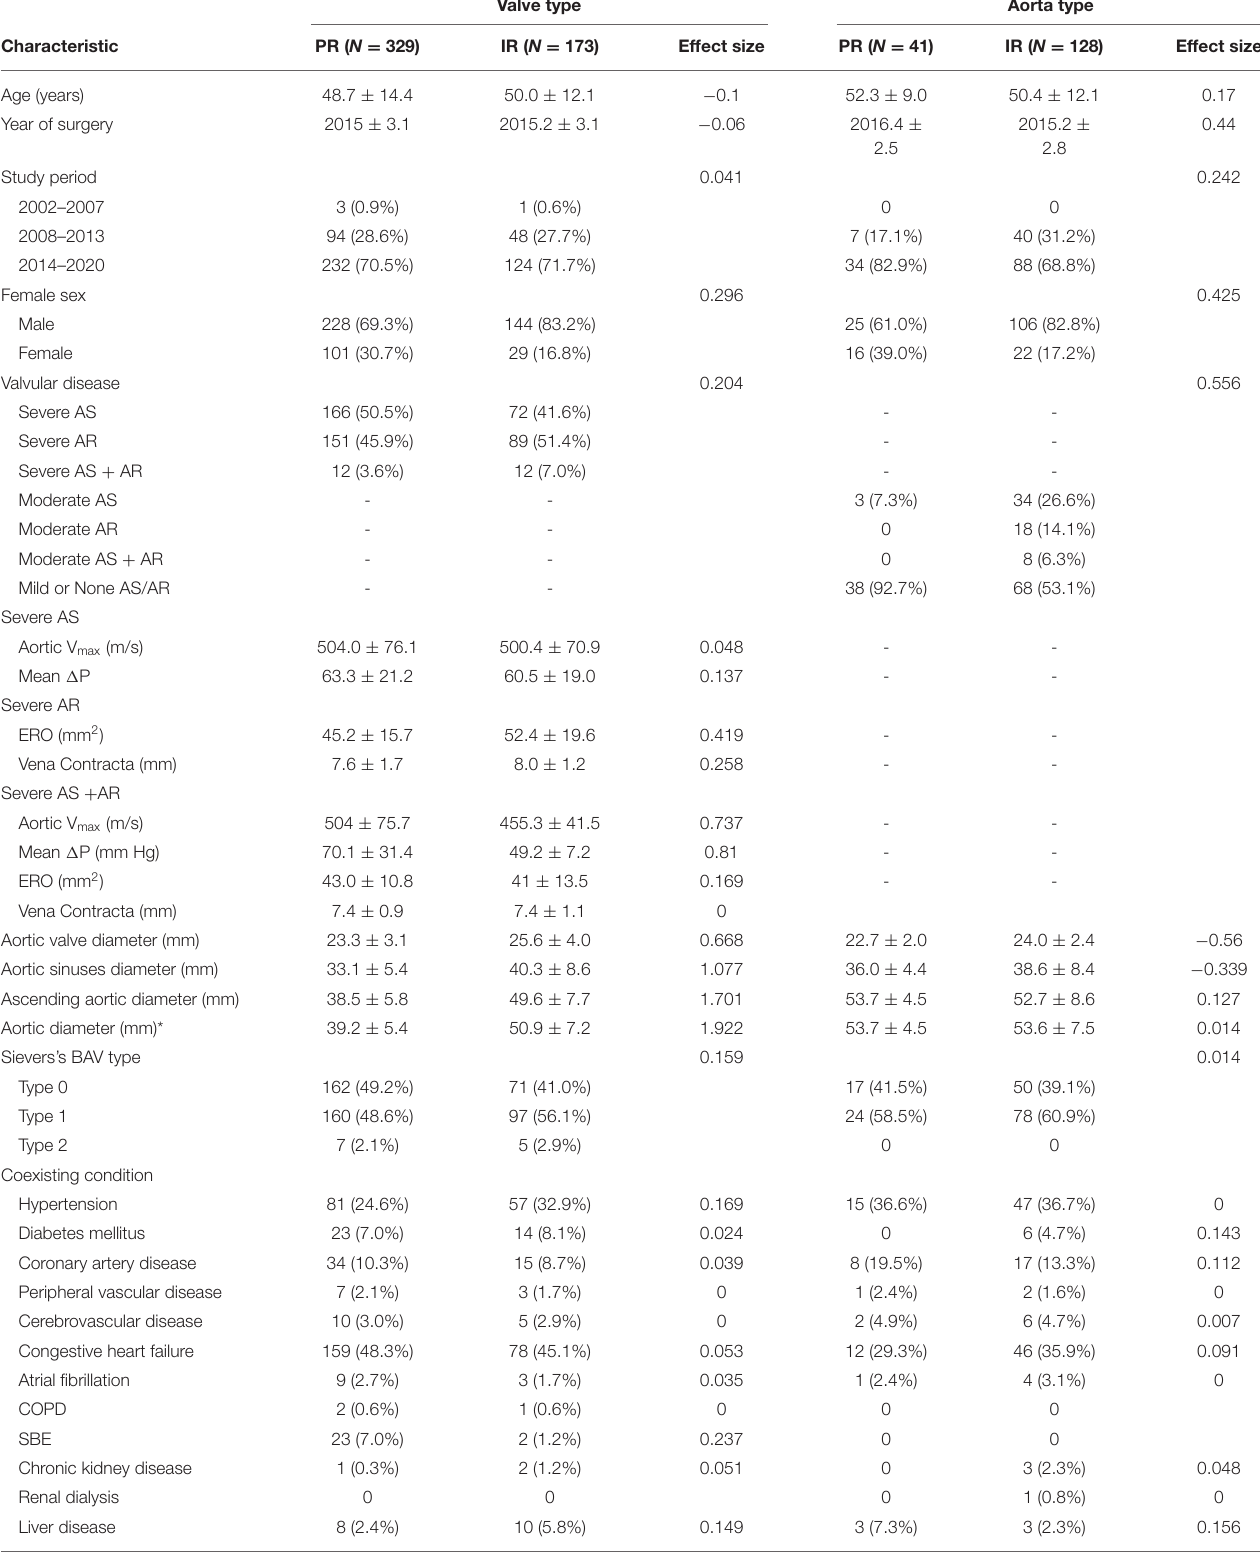
TABLE 1 | Baseline and operative characteristics before inverse probability